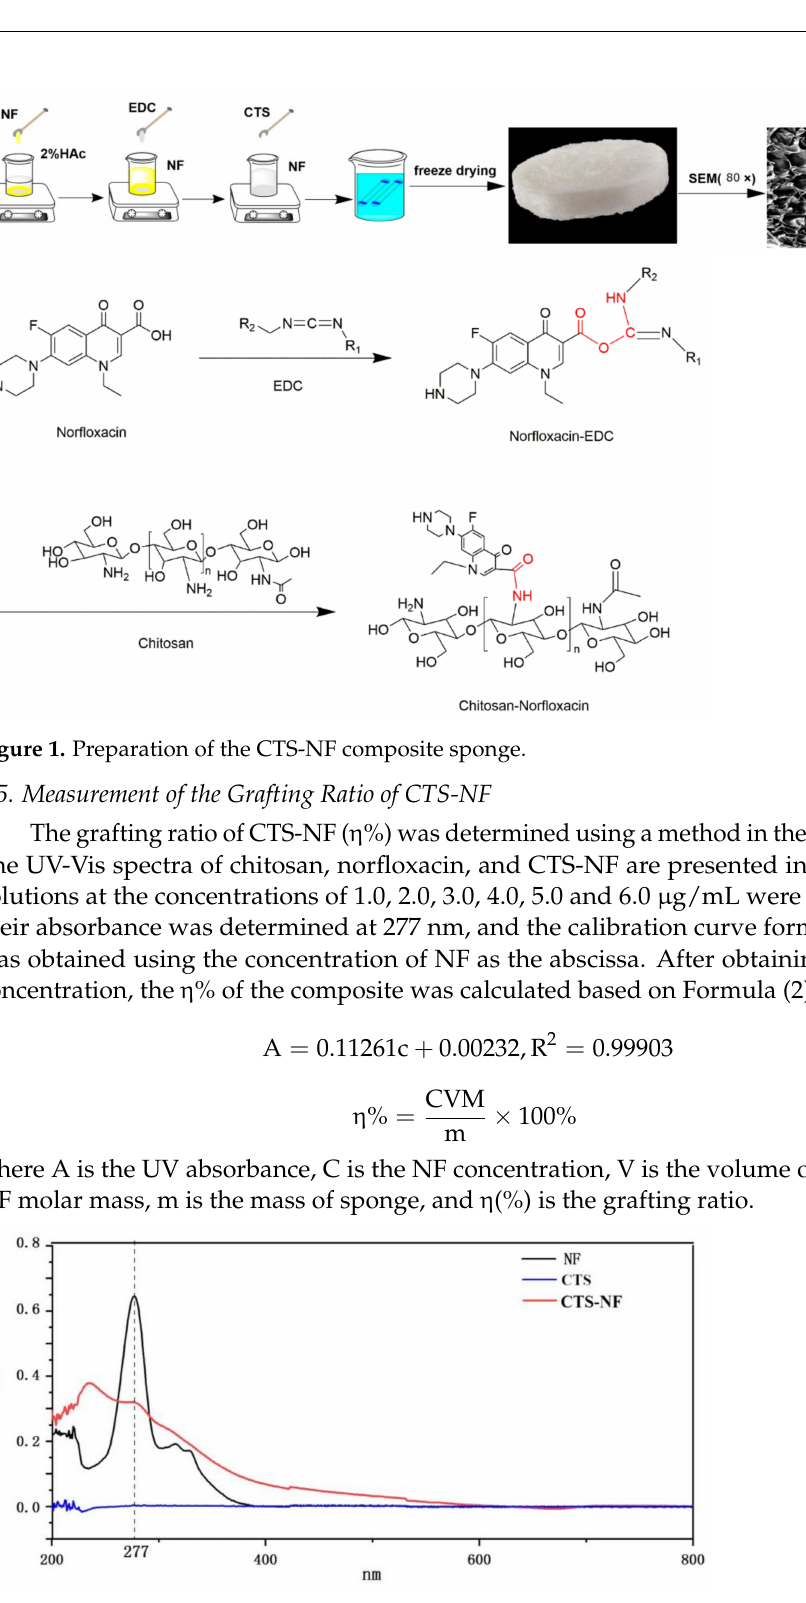
Figure 2. UV–Vis spectra of CTS, NF, and